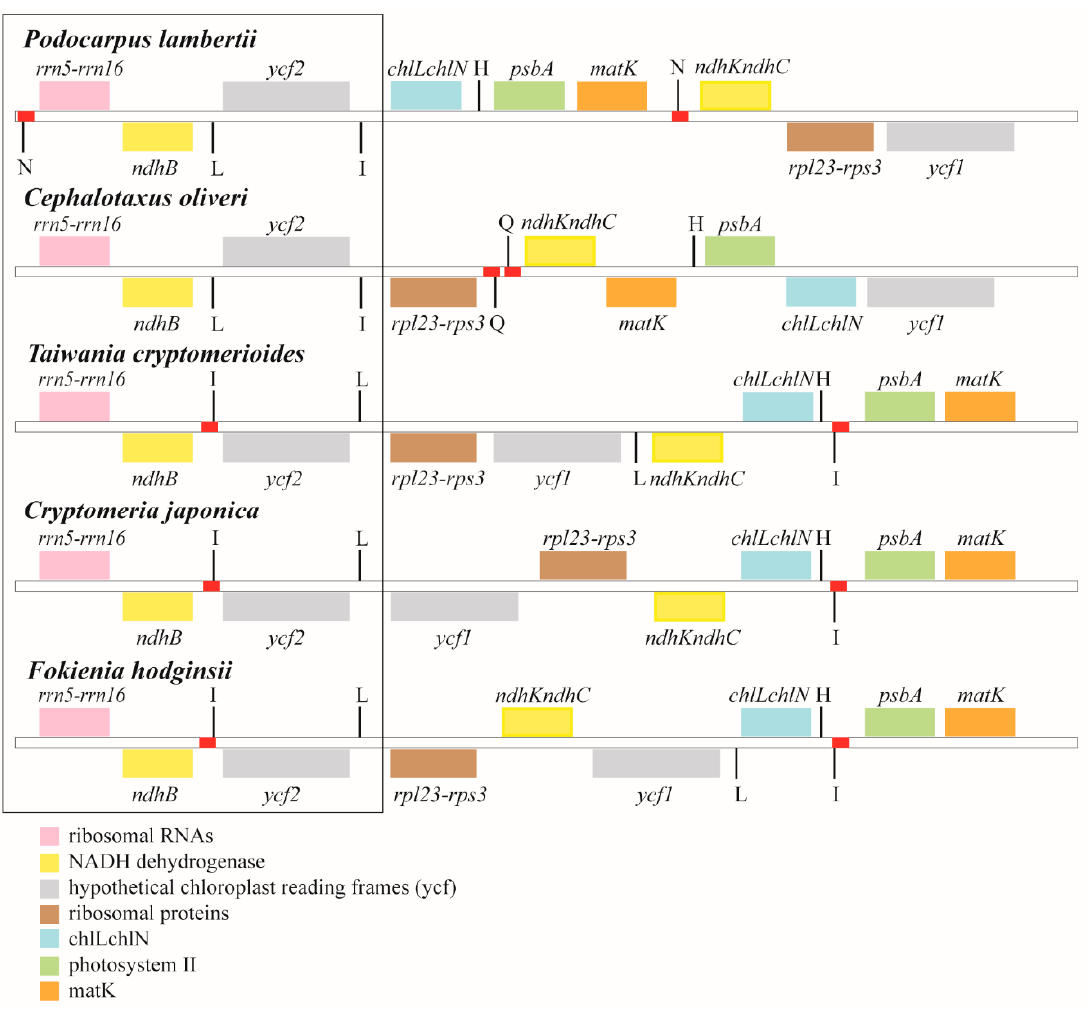
Figure 6. Comparisons of inverted repeat (IR) regions among five species from Cupressophyta. Genes located above the white strip were transcribed counter-clockwise, others below the strip were transcribed in the inverse direction. Different colors are used to distinguish gene functions. Single letters indicate the abbreviation of the transfer RNA. N for trnN-GUU , L for trnL-CAA , I for trnI-CAU , H for trnH-GUG , and Q for trnQ-UUG . The black frames represent the retained IR regions and the little red boxes show the track of short IR regions.